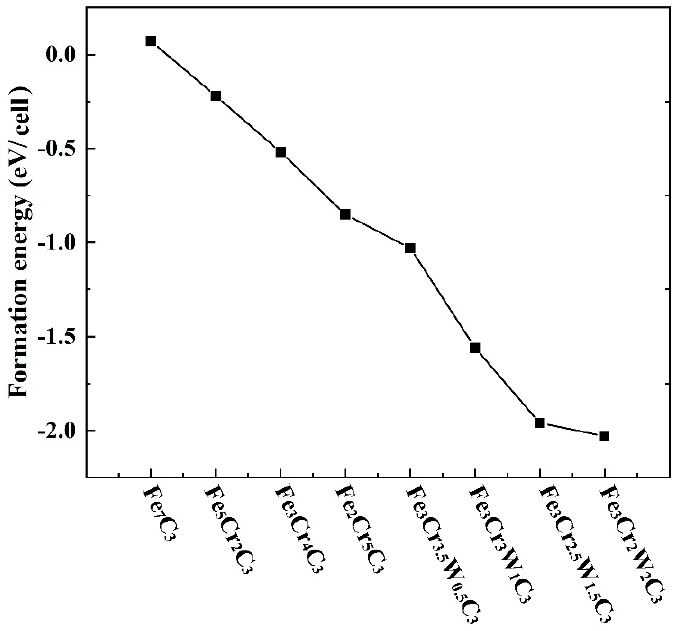
Figure 2. Calculated formation energy of M 7 C 3 carbides ( Δ E for, eV/cell).